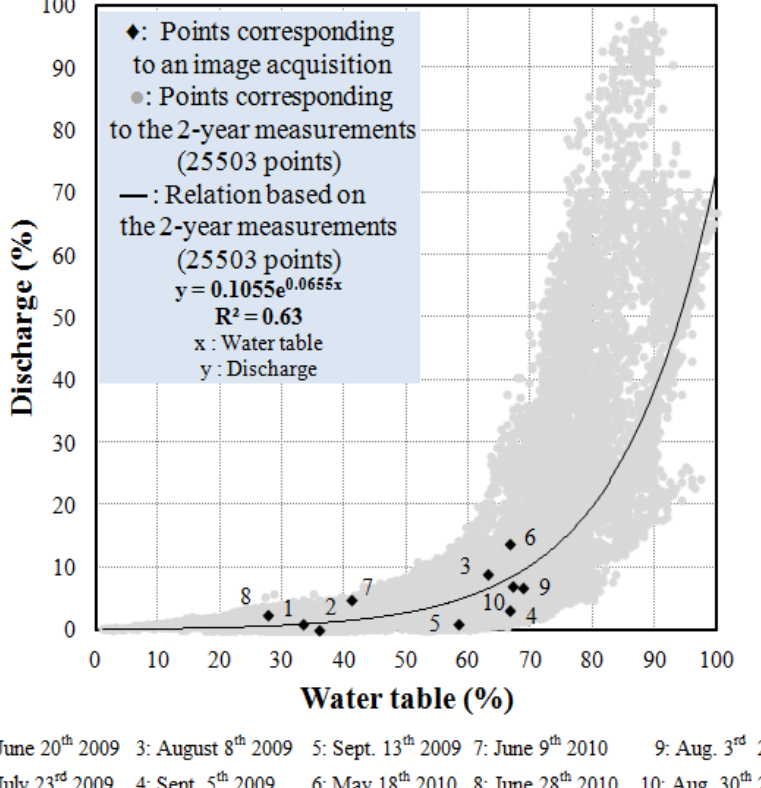
Figure 11. Discharge of the site 1 fen is related to the water table measured at well A. Discharge and water table data were collected every 15 minutes during the 2009 and 2010 snow-free seasons. The range of measured values is displayed in percentages, 100% corresponding to the maximal measured value (0% to the minimal). Black diamonds show discharge and water table values corresponding to image